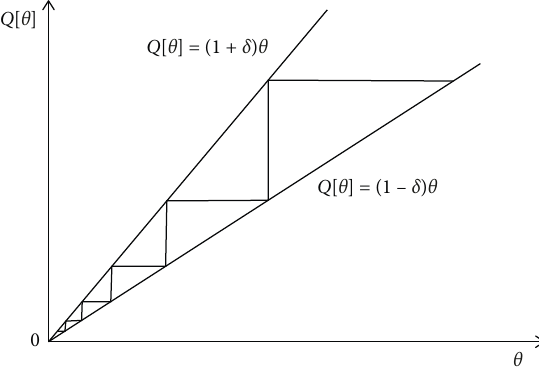
Figure 1: Logarithmic quantizer. Figure 2: Block diagram of observer-based quantized feedback